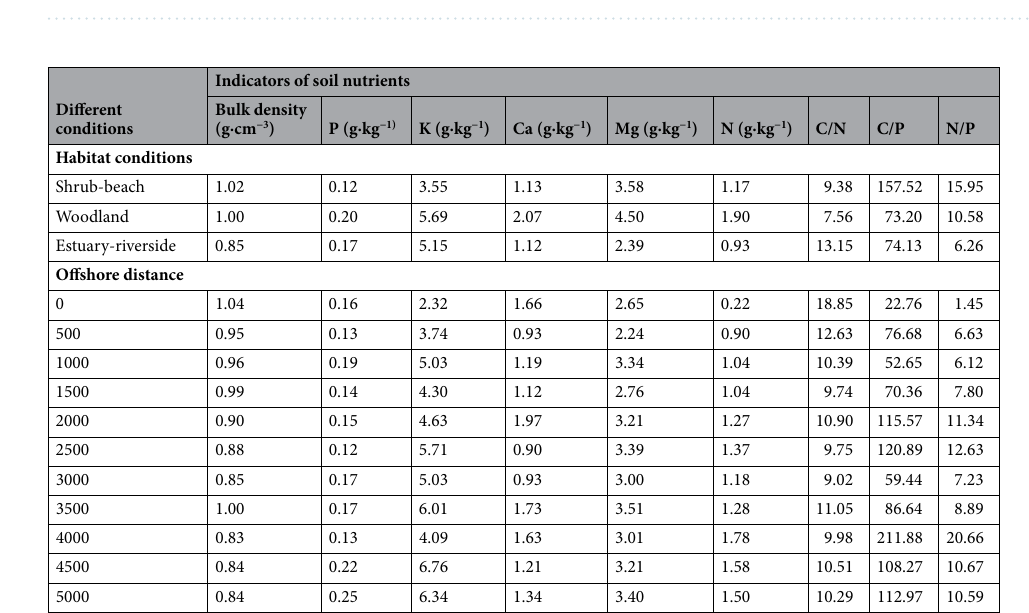
Figure 2. SOCD content of different types of soil.